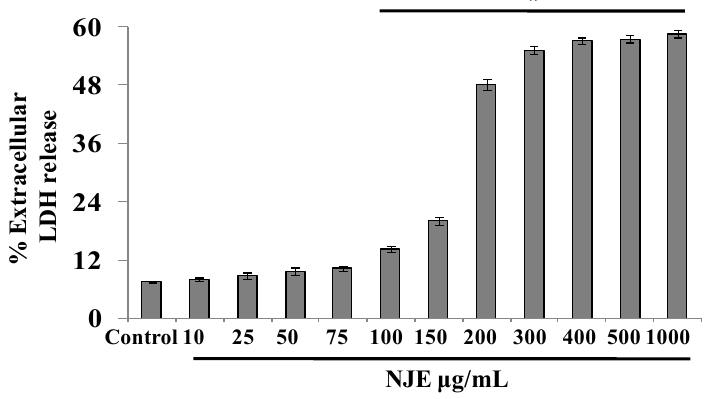
Figure 7. Effects of NJE on LDH release in SH-SY5Y neuronal cells (* p < 0.05 vs.